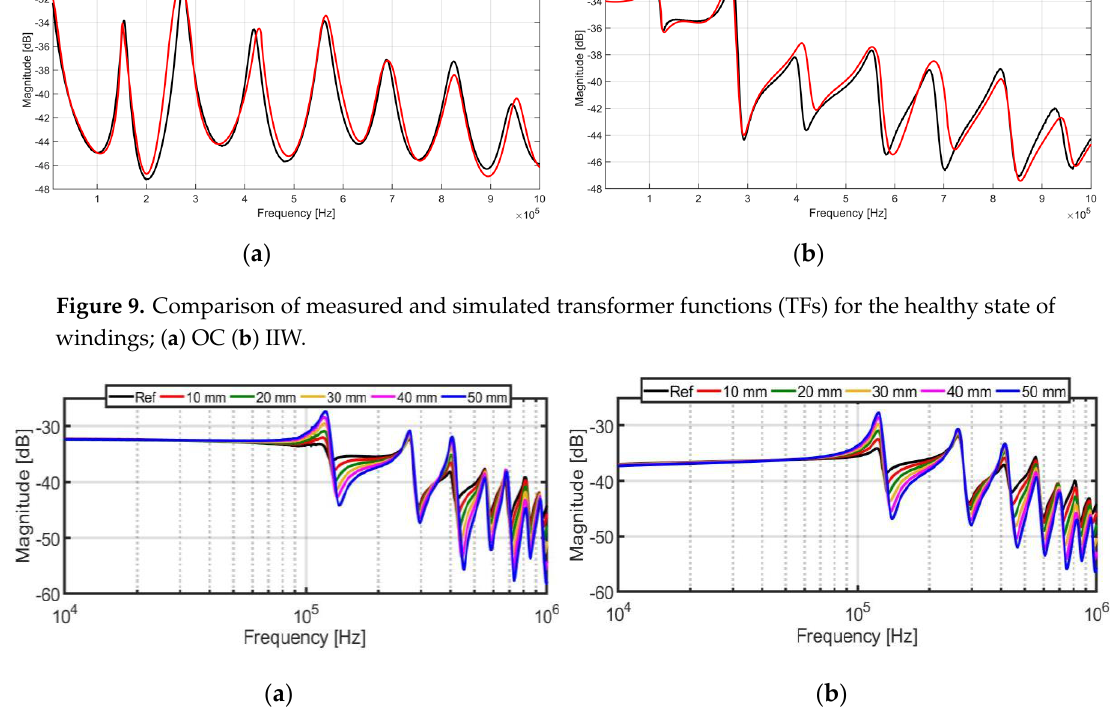
Figure 10. IIW TFs for different levels of axial displacement fault; ( a ) measurement ( b ) simulation.